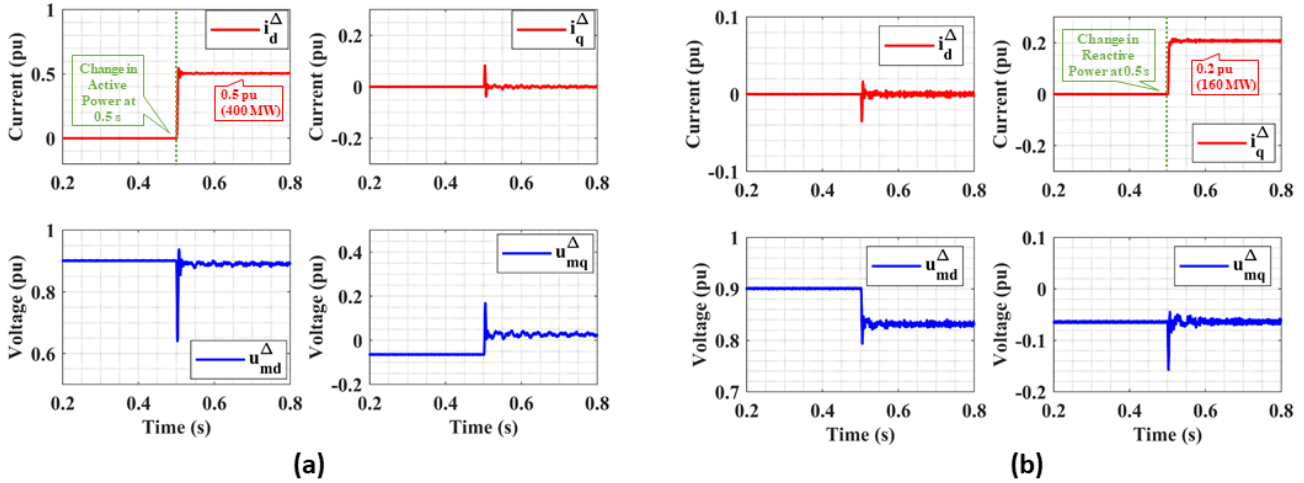
Figure 19. Change at the time instance t = 0.5 s in: ( a ) active power reference from 0 p.u. to 0.5 p.u.; ( b ) reactive power reference from 0 p.u. to 0.2